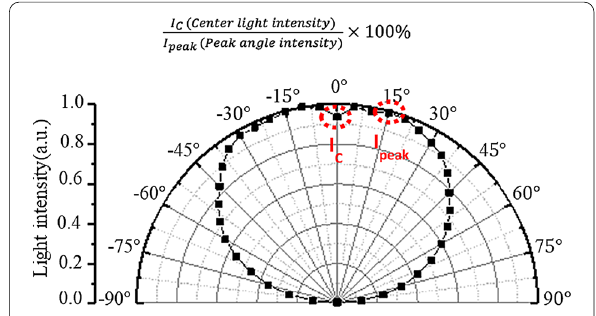
Fig. 1 Micro‑LEDs chip light distribution curve